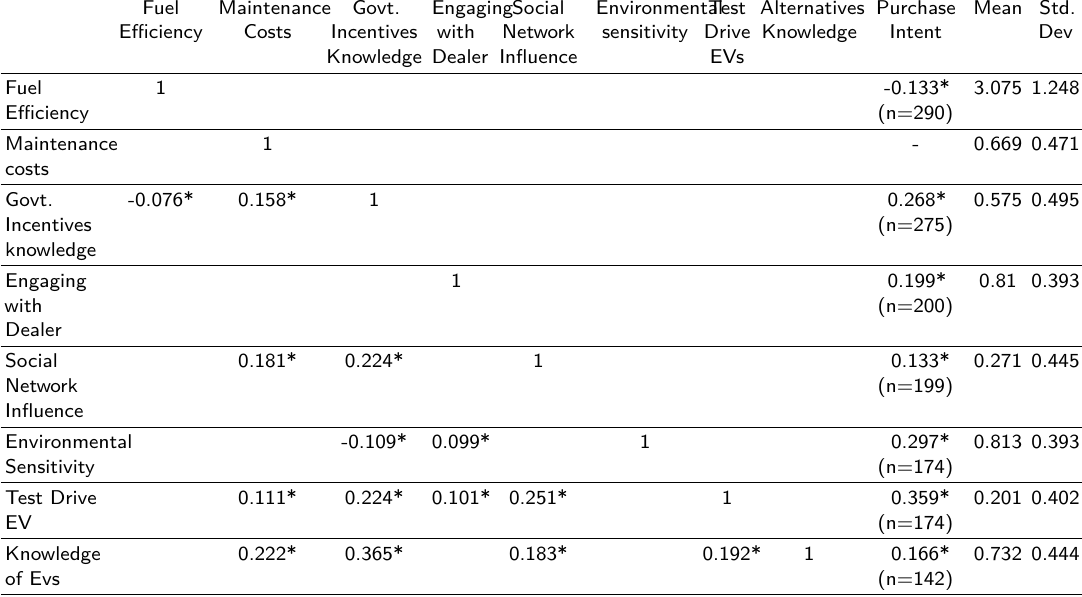
Table 5 . Statistically significant correlations (R) between inferential variables